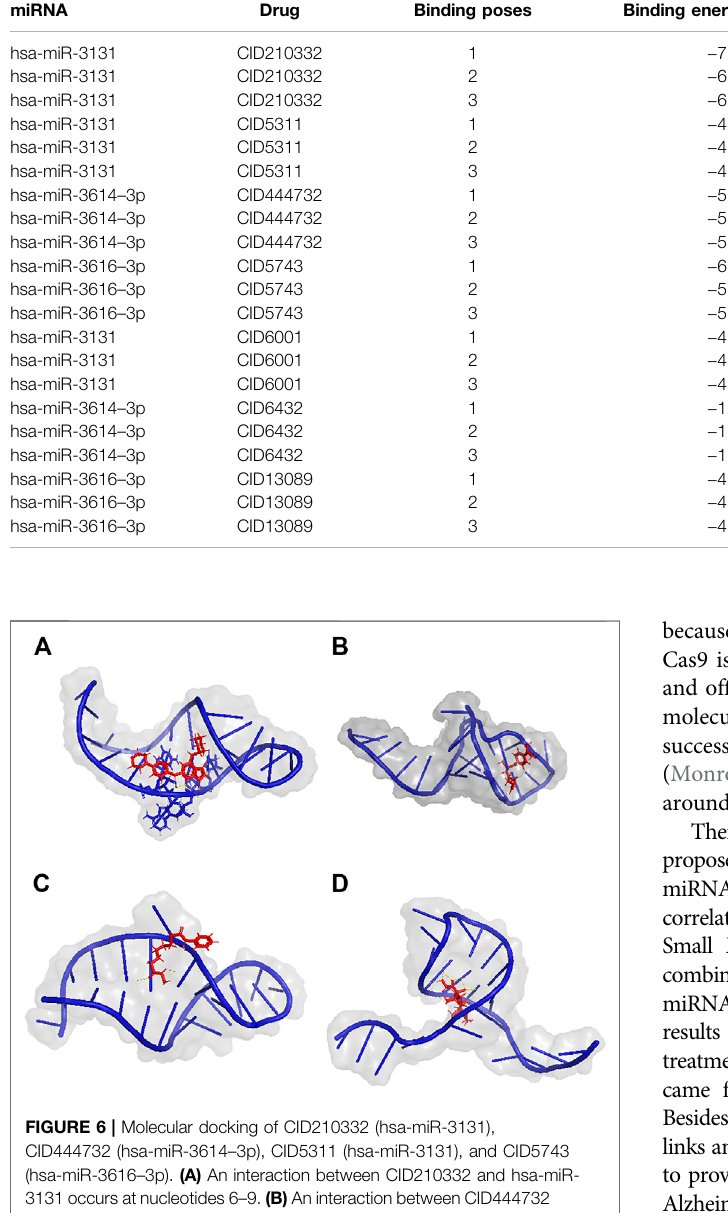
Frontiers in Molecular Biosciences |